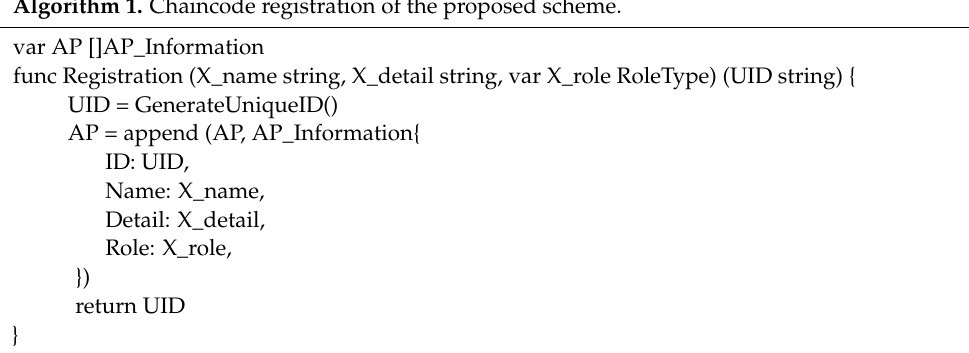
Algorithm 1. Chaincode registration of the proposed